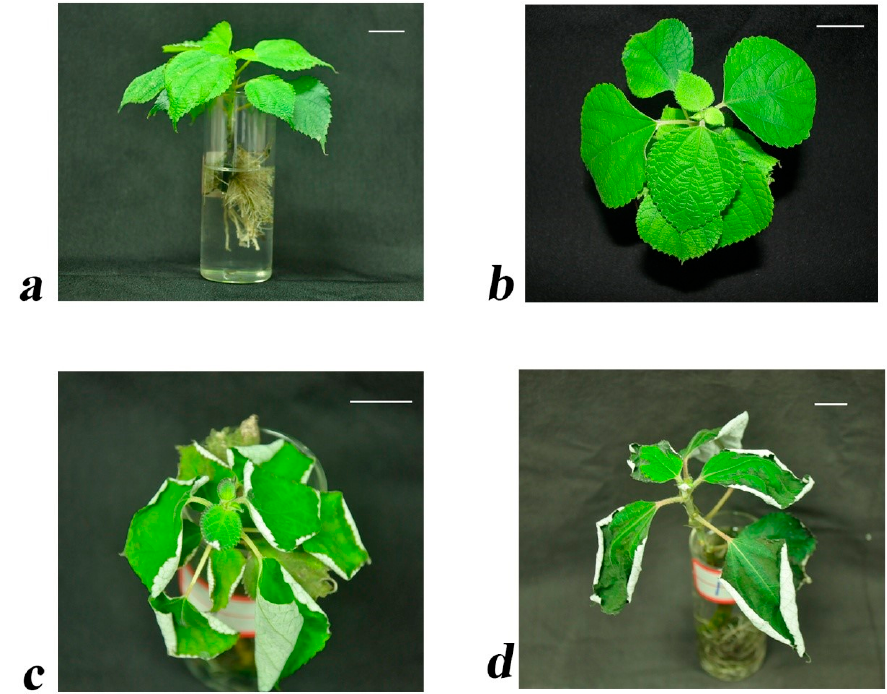
Figure 1. ( a ) After two-week propagation from stem cuttings, the plantlets of “Huazhu No. 5” were transplanted into half-strength Hoagland's solution for 20 days. Leaf and root samples of the same sizes were harvested at 0 h ( b ), 24 h( c ), and 72 h ( d ) after materials had been treated with 15% ( w / v ) PEG6000 to induce drought stress. They were cultured under cool white fluorescent light in 16/8 h (light/dark) with a relative humidity of 50%–70% and temperatures about 25 ± 2 °C in the daytime and 20 ± 2 °C at night. Scale bar = 2 cm.